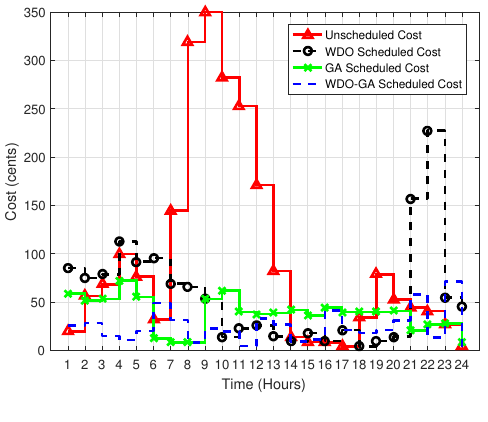
Figure 6. Total cost.